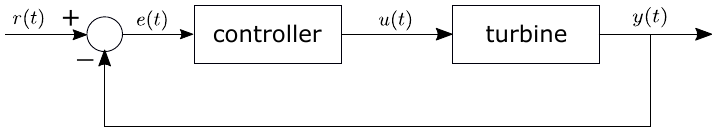
Figure 1. Common control